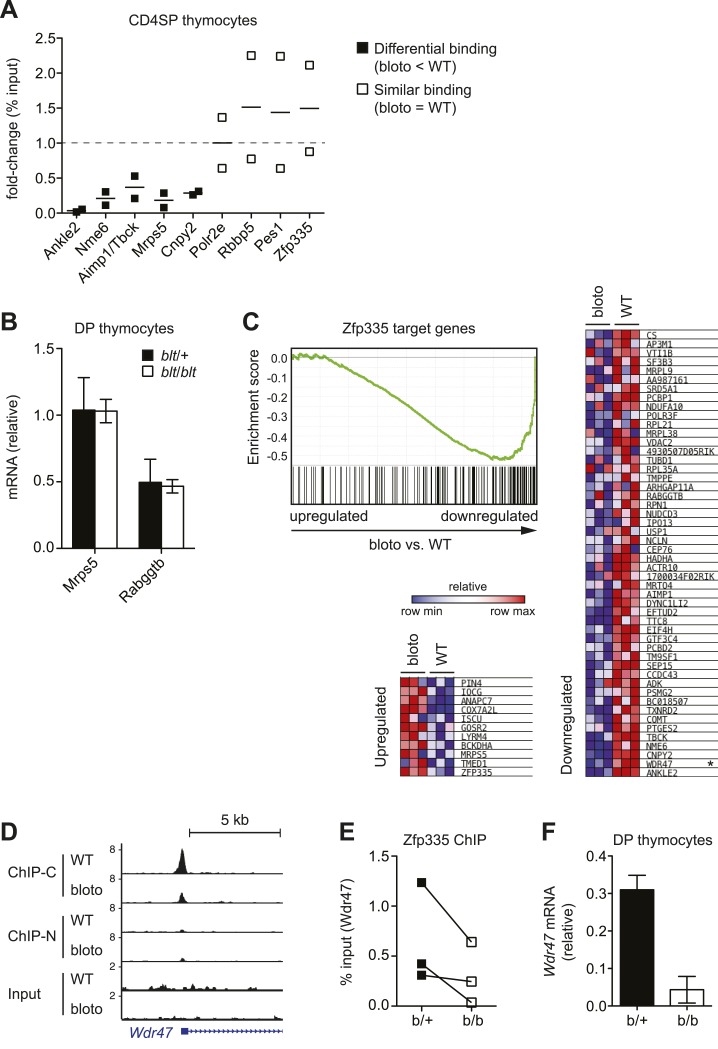
Analysis of correlation between changes in Zfp335 binding and gene
expression in blt/blt thymocytes.(A) ChIP-qPCR analysis of Zfp335 binding at selected targets
in sorted CD4SP thymocytes. ChIP enrichment was calculated as percent
input; results are presented as the fold-change in ChIP enrichment for
blt/blt vs WT for two biological replicates.
(B) Quantitative RT-PCR analysis of
Mrps5 and Rabggtb mRNA in sorted DP
thymocytes (mean ± s.d., n = 3). (C) GSEA
plot comparing expression values of Zfp335 target genes (TSS within ±1 kb
of a Zfp335 peak) in blt/blt vs WT mature CD4SP
thymocytes (left). Heatmaps depicting relative expression of the top 50
downregulated (right) and top 11 upregulated (bottom left) target genes;
Wdr47 is marked with an asterisk. (D)
ChIP-seq signal tracks showing Zfp335 occupancy at
Wdr47, a target gene for which reduced Zfp335 binding is
detected in the ChIP-C but not ChIP-N data set. (E)
ChIP-qPCR confirmation of reduced Zfp335 binding to the
Wdr47 promoter. Antibody used was specific for
C-terminal epitope of Zfp335. ChIP enrichment represented as % input;
matched data points for blt/+ (filled symbols) vs
blt/blt (open symbols) thymocytes
from three independent ChIP experiments shown. (F)
Quantitative RT-PCR analysis of Wdr47 mRNA in sorted DP
thymocytes (mean ± s.d., n = 2–3).